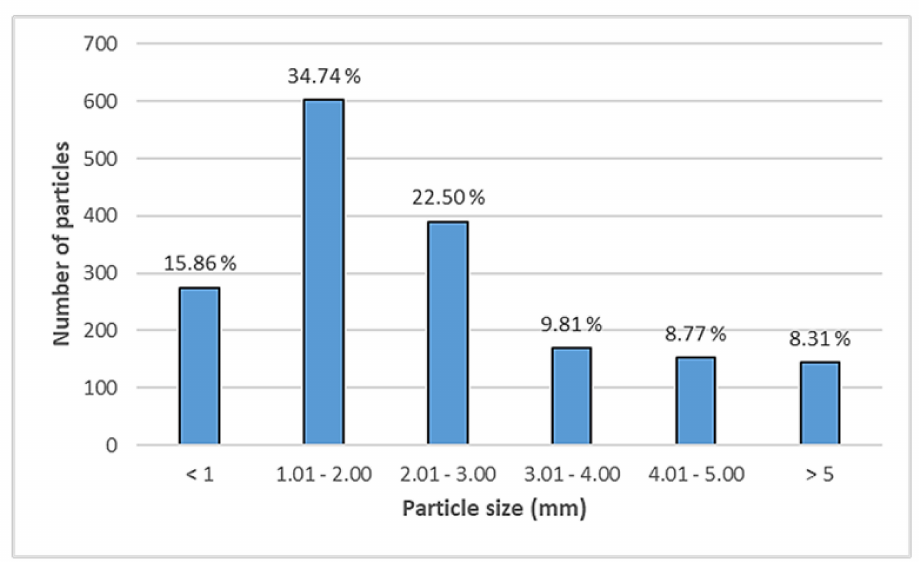
Figure 2. Particle-size distribution of microplastics in the center of the Mediterranean Sea.